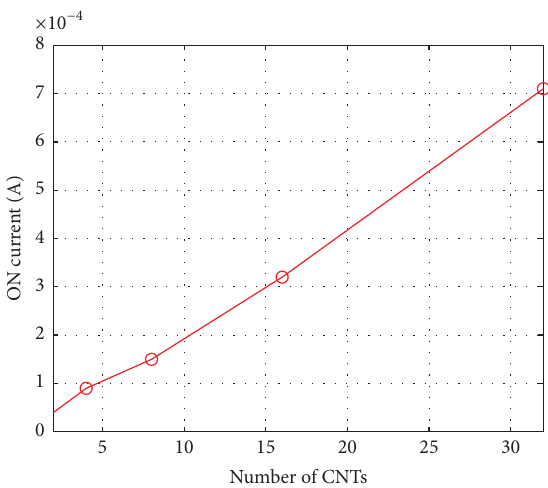
Figure 2: Effect of CNT diameter on the power consumption.